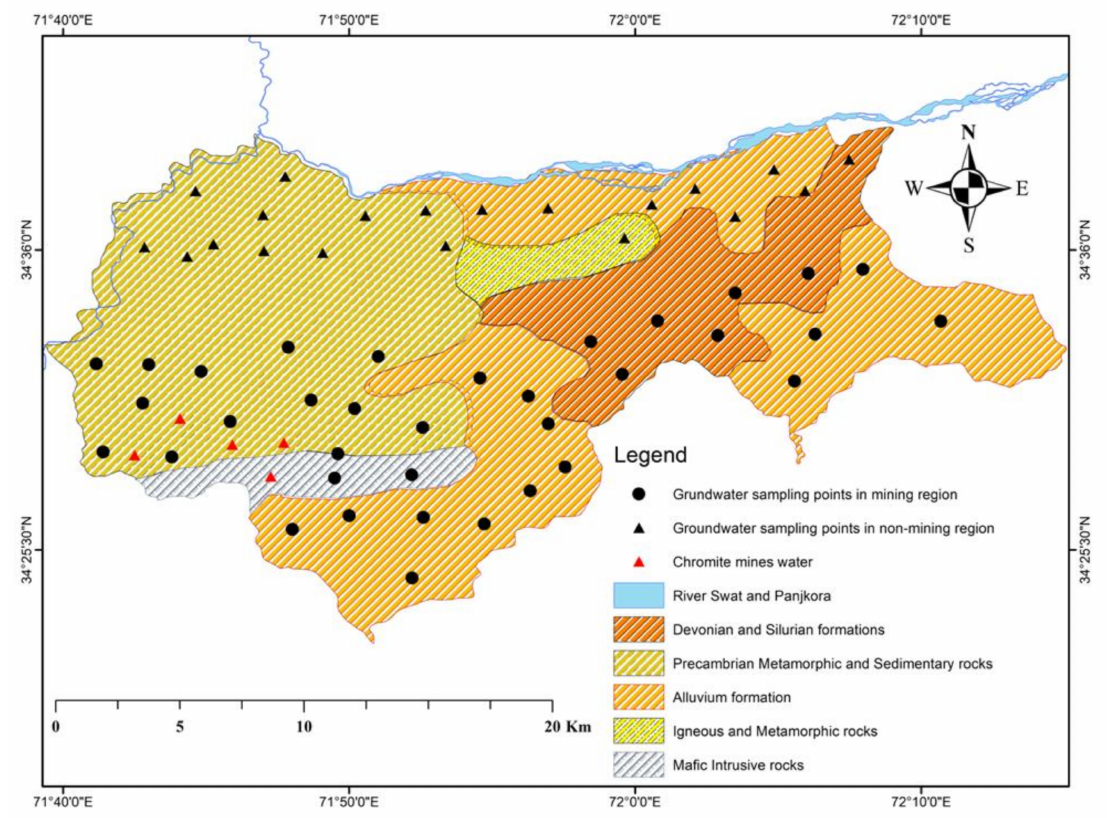
Figure 1. Map showing groundwater samples and geological formations of the